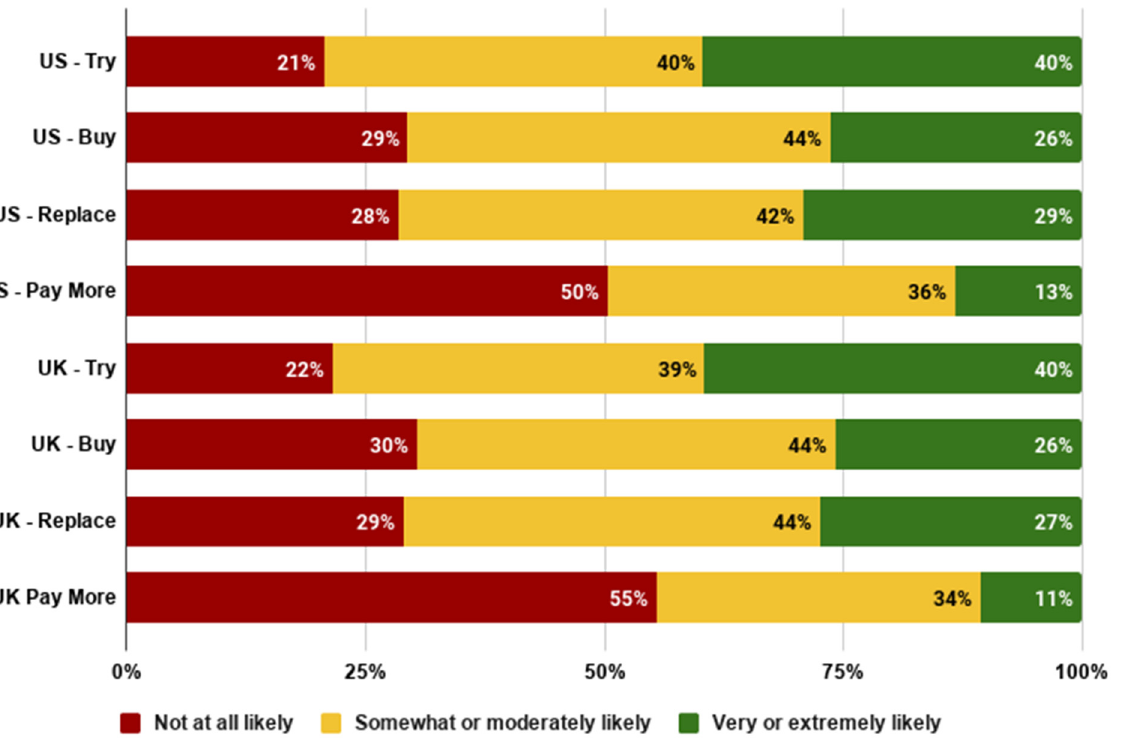
Figure 9. Likelihood of adopting cultivated meat in the US and UK among the general population.